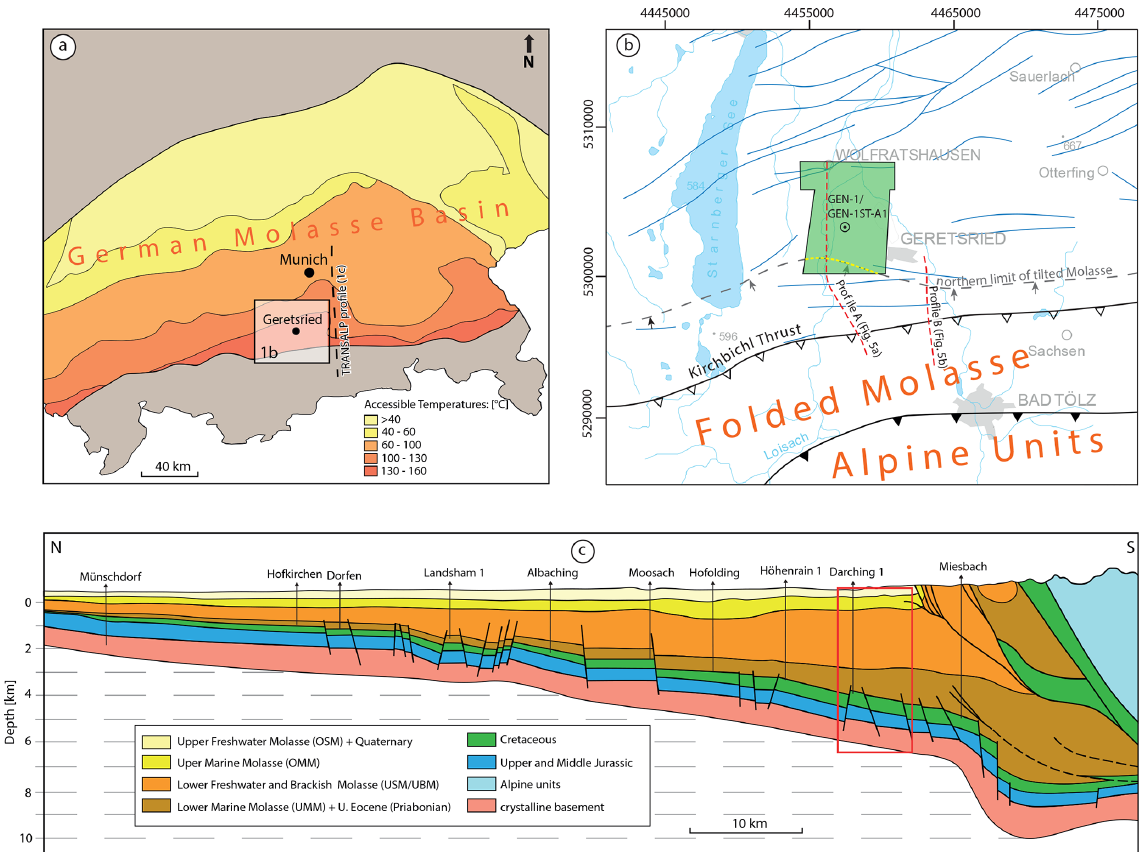
Figure 1. (a) Outline of the German Molasse Basin with geothermal areas (Agemar et al., 2014). The black box marks area shown in panel (b) . The dashed black line shows the location of the regional cross-section in panel (c) . (b) Close-up of the study area, showing the extent of the 3-D seismic survey, the location of two seismic profiles, and well GEN-1. Blue lines are traces of major normal faults in the Upper Jurassic carbonate platform (GeoMol Team, 2005). The dashed grey line marks the N limit of the tilted Molasse according to the tectonic map of the Folded Molasse by Ortner et al. (2015). The dashed yellow line shows the N extent of the Geretsried fold. (c) Simplified cross-section across the Molasse Basin, based on the interpretation of the seismic TRANSALP profile (after Lüschen et al., 2006), located 30km to the east of the study area. The red box marks the projection of the study